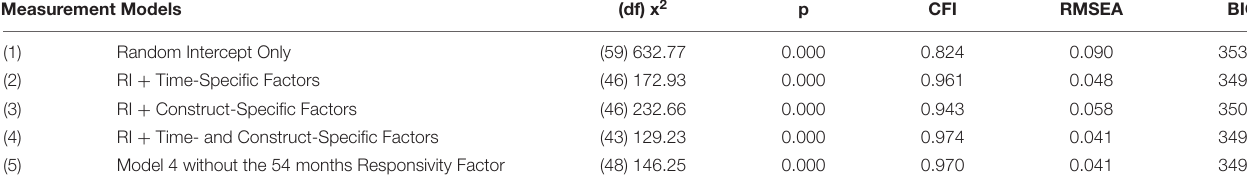
TABLE 3 | Fit indices for measurement models of the home scales.